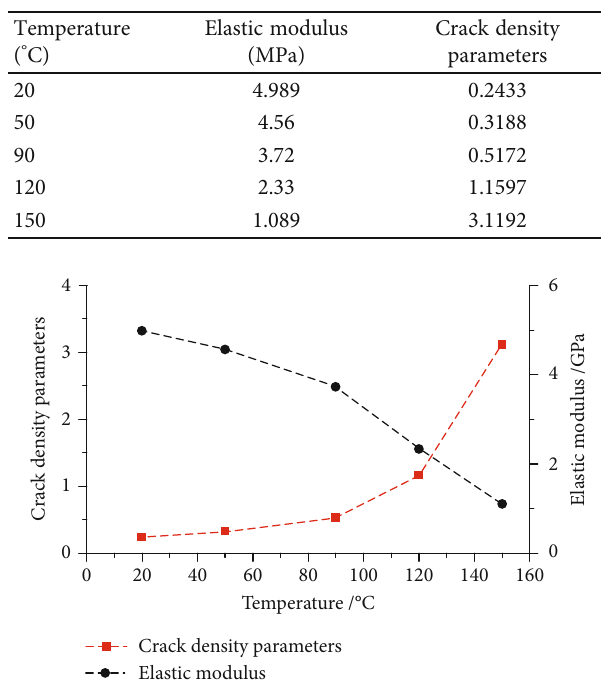
Figure 14: Crack density parameter curve of salt rock at di ff erent